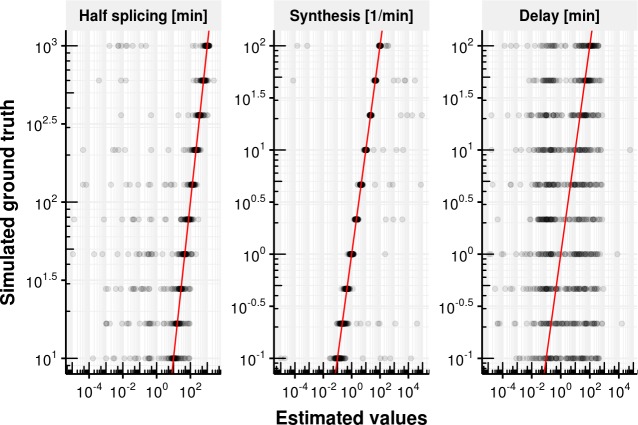
Evaluation of delay model fitting.Estimated splicing half-time (log2β), synthesis rate α and delay time δ on the x-axis vs. simulated ground truth half-life, synthesis rate and delay. The red line shows the identity line. Most estimates are close to the identity line except for the delay.